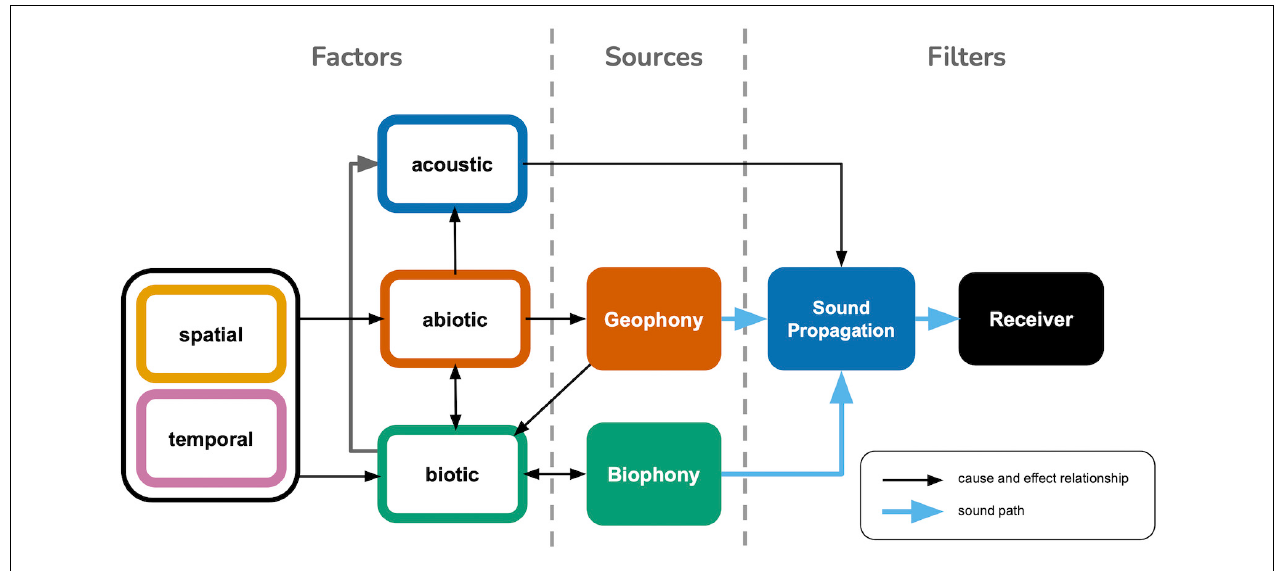
FIGURE 1 | Simplified soundscape functional block diagram. Environmental factors, sound sources and acoustic filters are represented through a source-filter approach. The influence of geophony and biophony on biotic factors introduce feedback loops that partially explain the complexity of soundscape